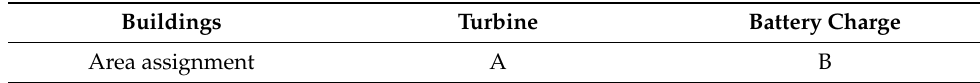
Table 4. Small flooded area selection, NPP 2.